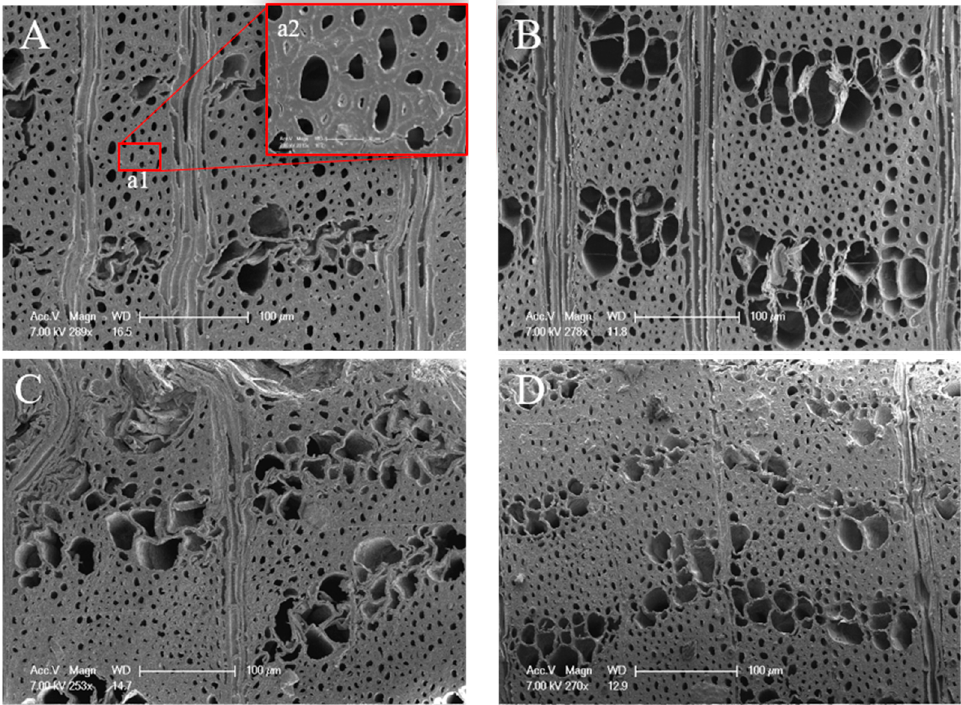
Figure 6. SEM pictures of the transverse section of elm wood samples. A , B , C and D were the results from S1, S2 S3 and S4 respectively. a2, which was randomly choose in A, is 8 times larger than